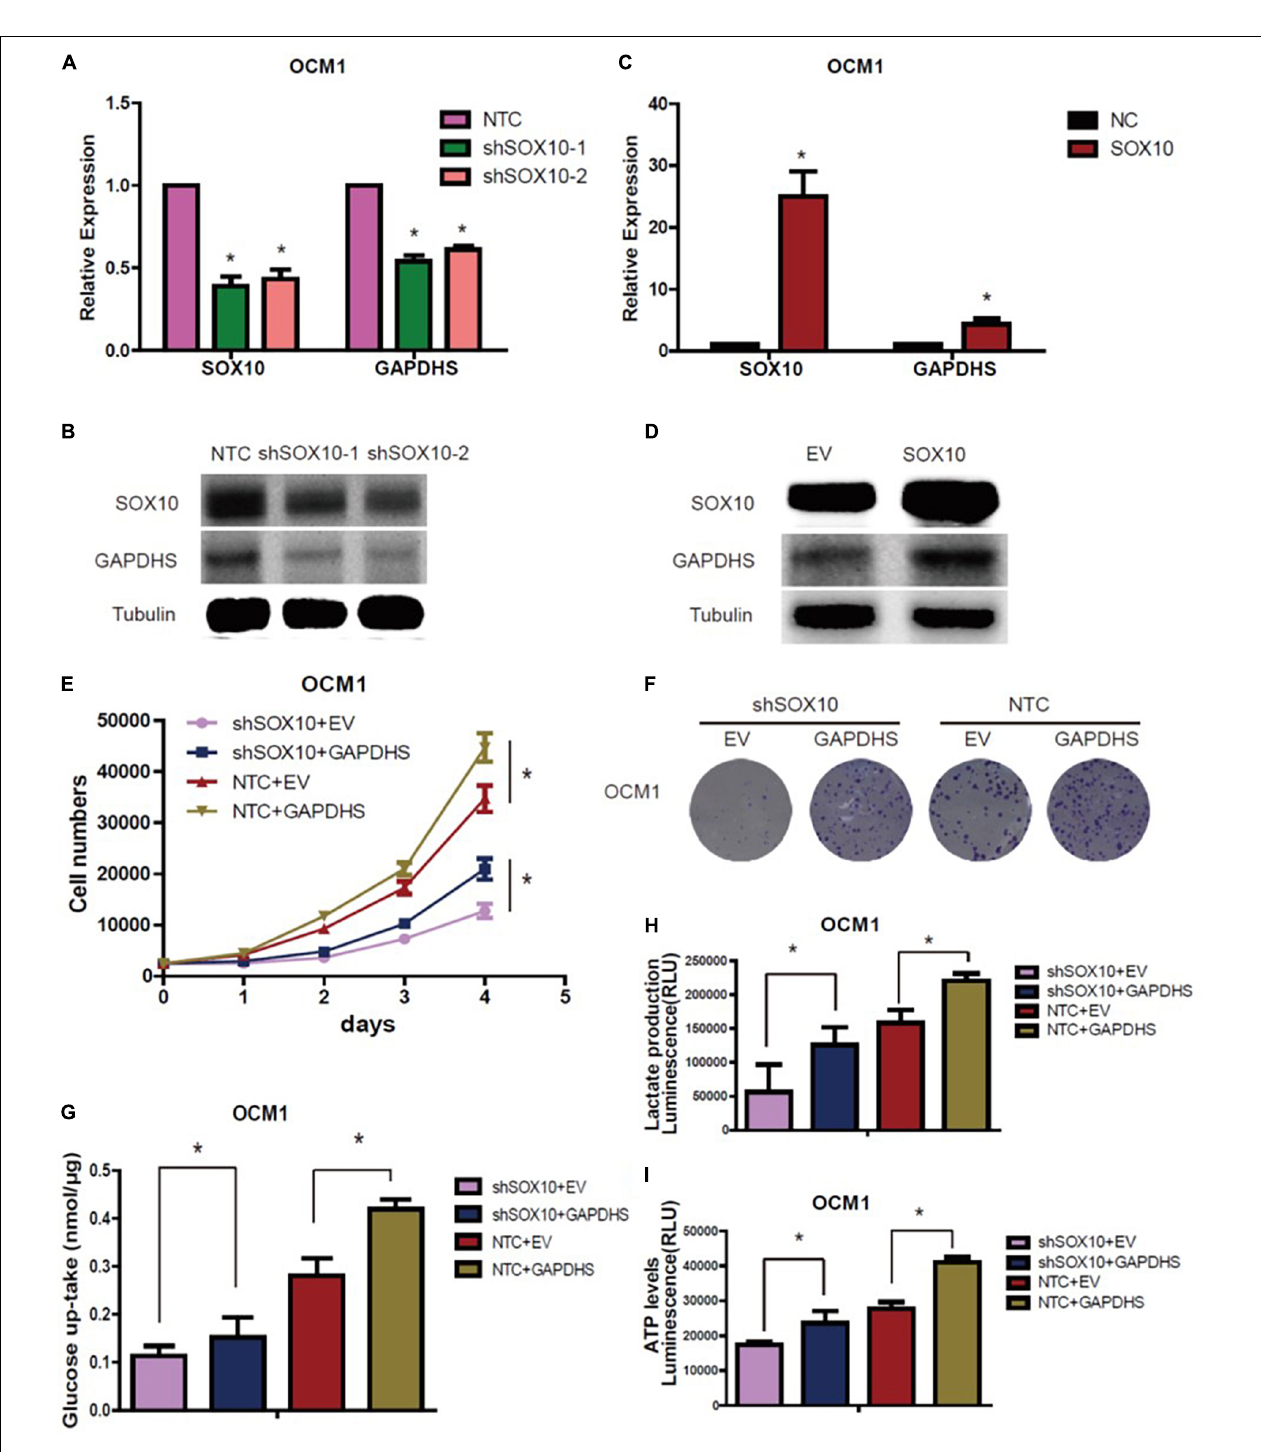
FIGURE 6 | GAPDHS is a direct target of SOX10 in vitro . (A,B) GAPDHS expression was measured by real-time PCR and western blotting in OCM1 cells expressing non-targeting control (NTC) or two shRNAs (shSOX10-1 and shSOX10-2) of SOX10. Tubulin served as the loading control. (C,D) GAPDHS expression was measured by real-time PCR and western blotting in OCM1 cells overexpressing control (EV) or SOX10. Tubulin served as the loading control. (E–I) OCM1 cells stably expressing NTC or shSOX10 were infected with viruses overexpressing GAPDHS, followed by measurement of cell growth (E) , tumor colony forming ability (F) , cellular glucose uptake (G) , lactate production (H) , and ATP levels (I) . Data are presented as the mean ± SE. * P < 0.05.